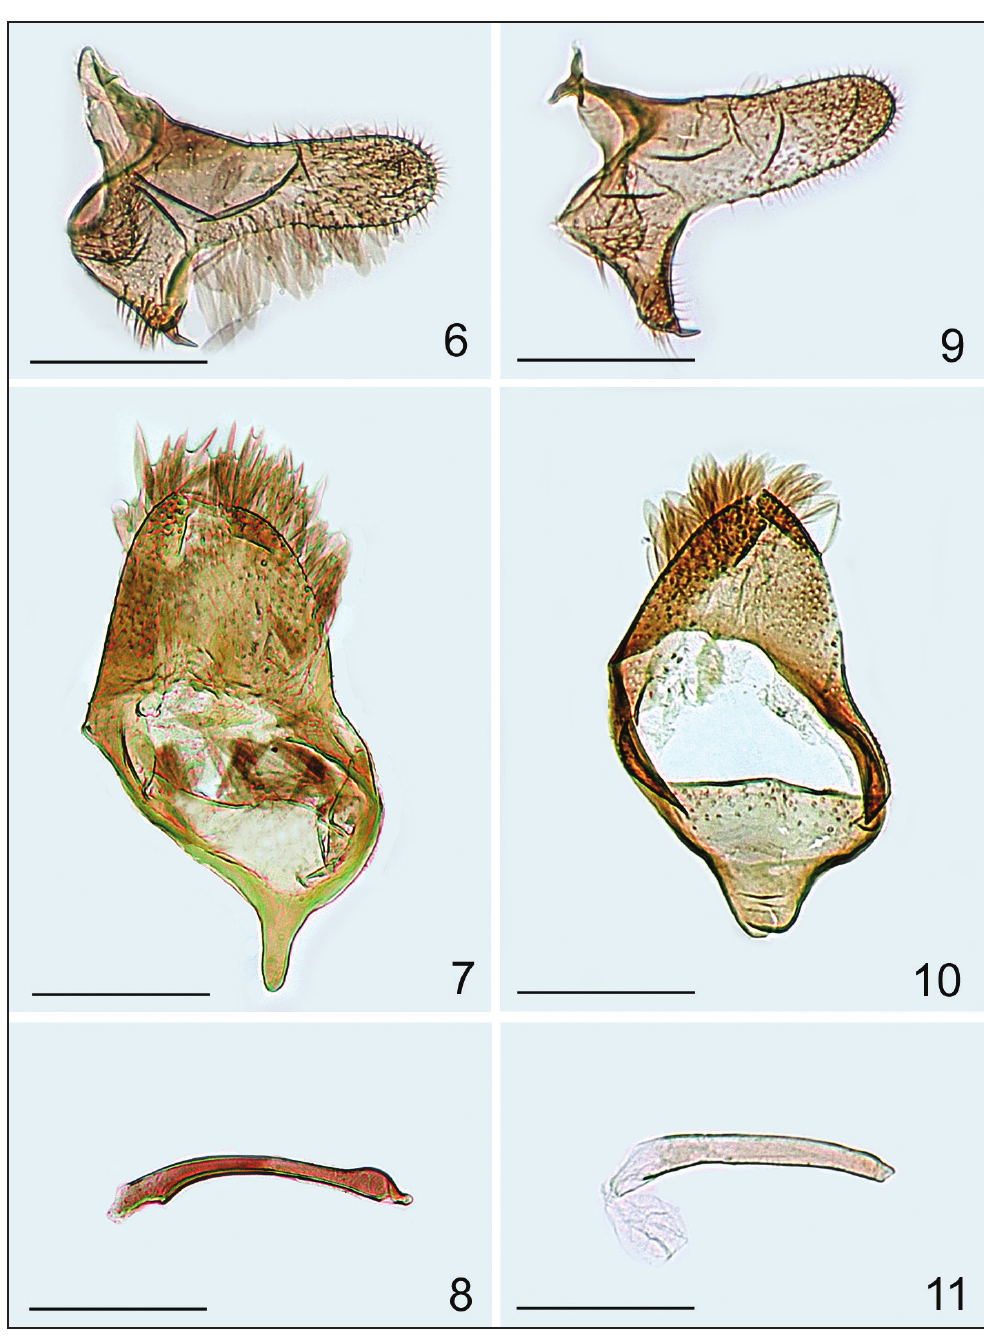
Figures 6–11. Details of male genitalia. Bankesia desplatsella (slide: 925 Bertaccini): 6. valva; 7. vincu- lum and saccus; 8. phallus. Taleporia defoliella (slide: 927 Bertaccini): 9. valva; 10. vinculum and saccus; 11. phallus. Scale bar 0.2